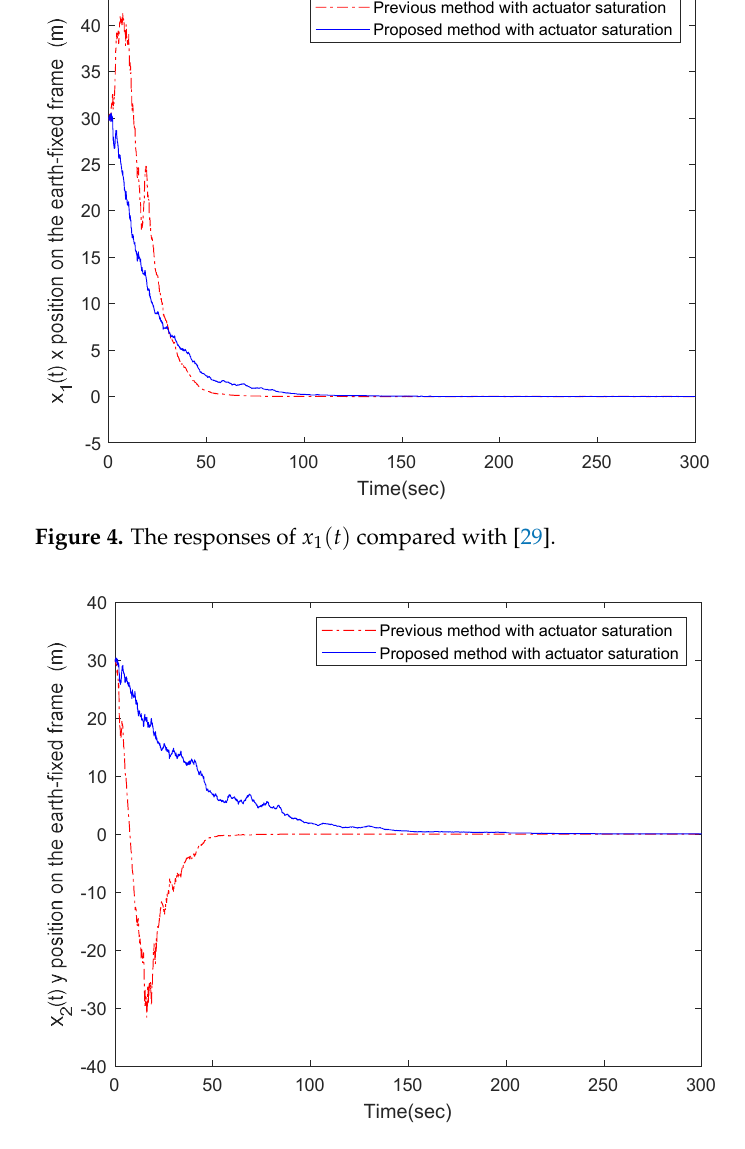
Figure 5. The responses of  